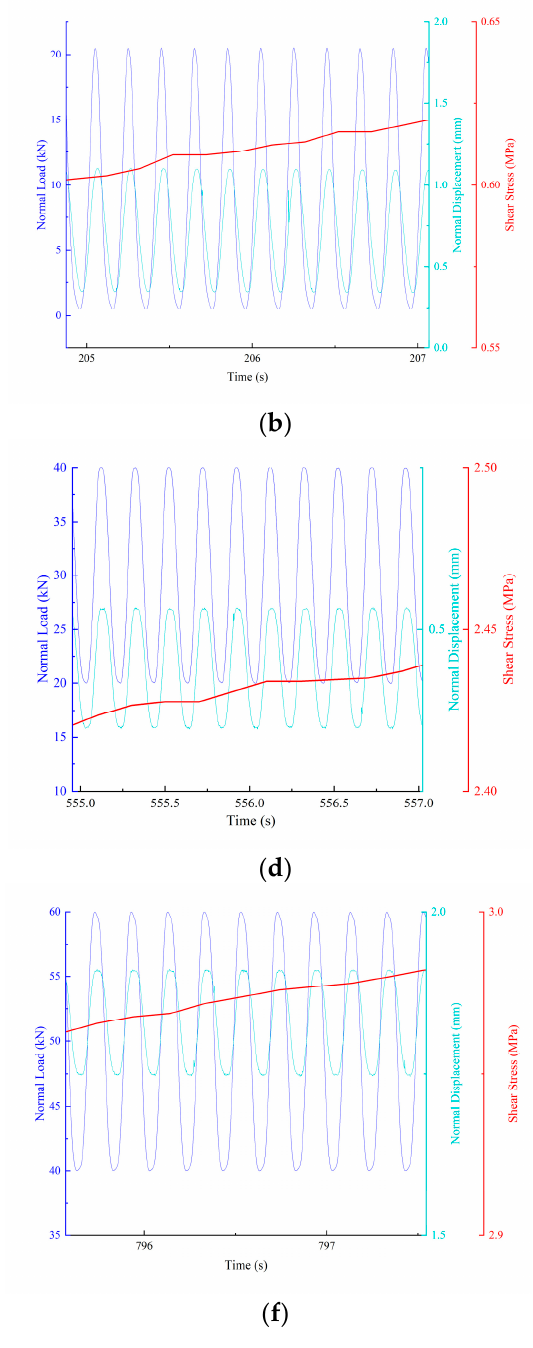
Figure 7. Shear stress, normal displacement and normal load with time under different dynamic normal loads. ( a ) Under 10 kN dynamic normal load. ( b ) Partial enlarged view of ( a ). ( c ) Under 30 kN dynamic normal load. ( d ) Partial enlarged view of ( c ). ( e ) Under 50 kN dynamic normal load. ( f ) Partial enlarged view of ( e ).